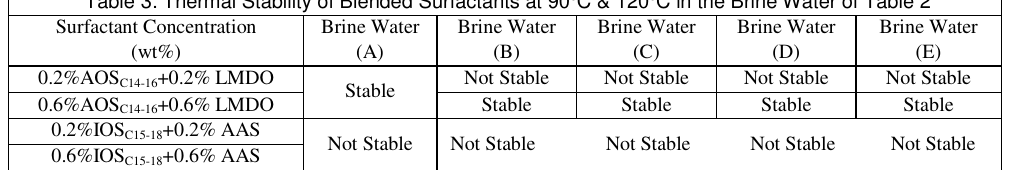
Table 3: Thermal Stability of Blended Surfactants at 90 o C & 120 o C in the Brine Water of Table 2 Surfactant Concentration